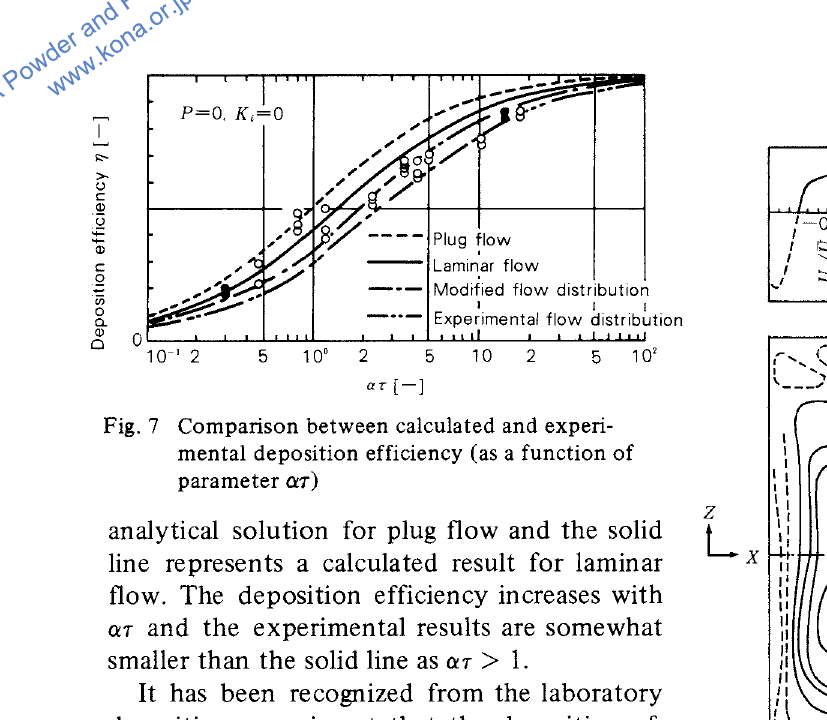
Fig. 7 Comparison between calculated and experi mental deposition efficiency (as a function of parameter <X7)